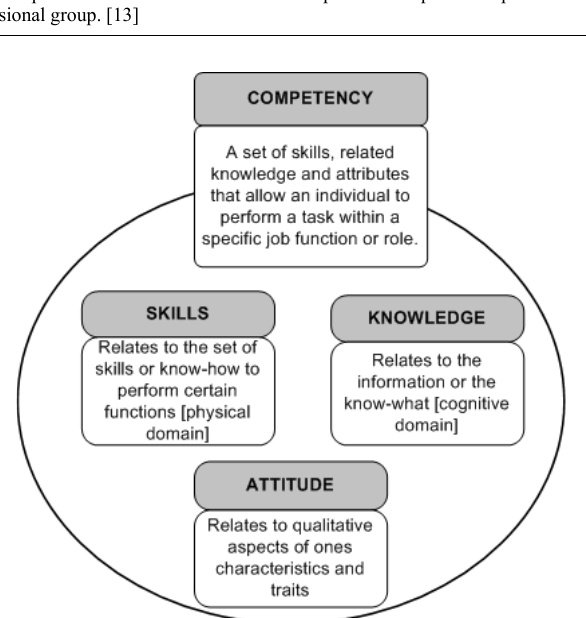
Figure 1. A deeper look into competency